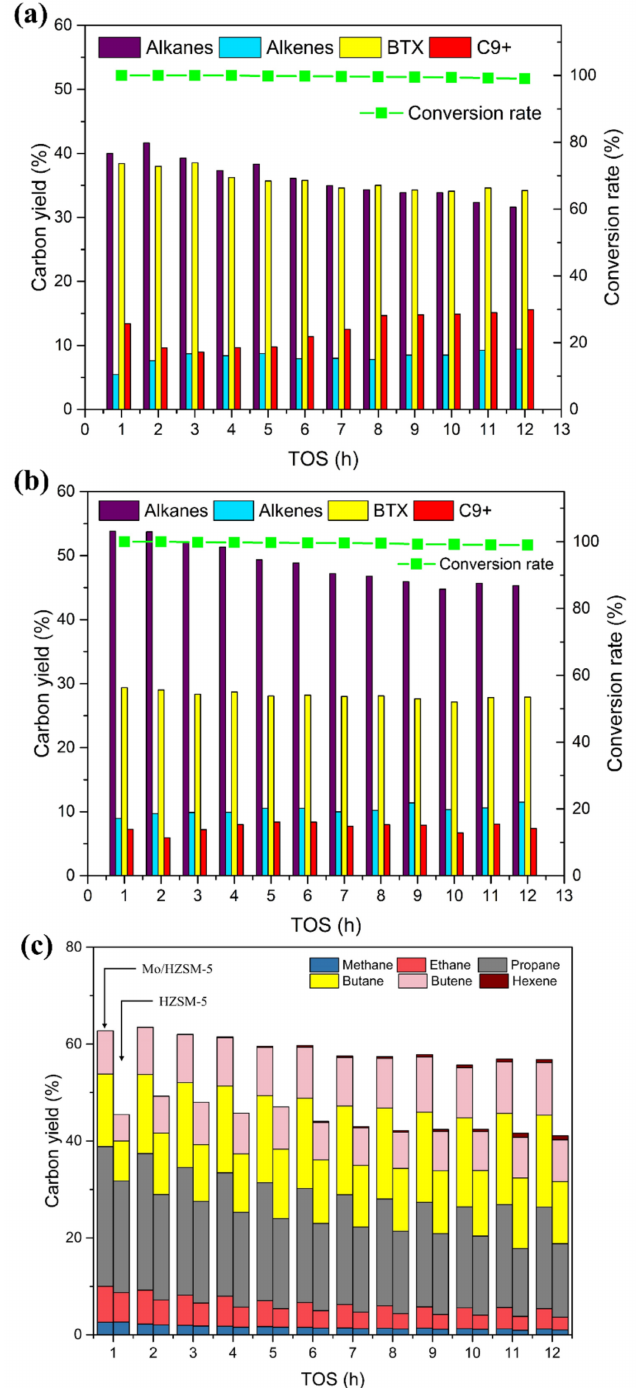
Figure 4. The results of HDO of acetone at 30 bar hydrogen pressure ( a ) conversion rate and major product groups distribution of HZSM-5, ( b ) conversion rate and major product groups distribution of Mo/HZSM-5, ( c ) detailed aliphatic product distribution, catalytic temperature: 400 ◦ C, hydrogen pressure: 30 bar, W/F = 0.073 g cat (mmol feed h − 1 ) − 1